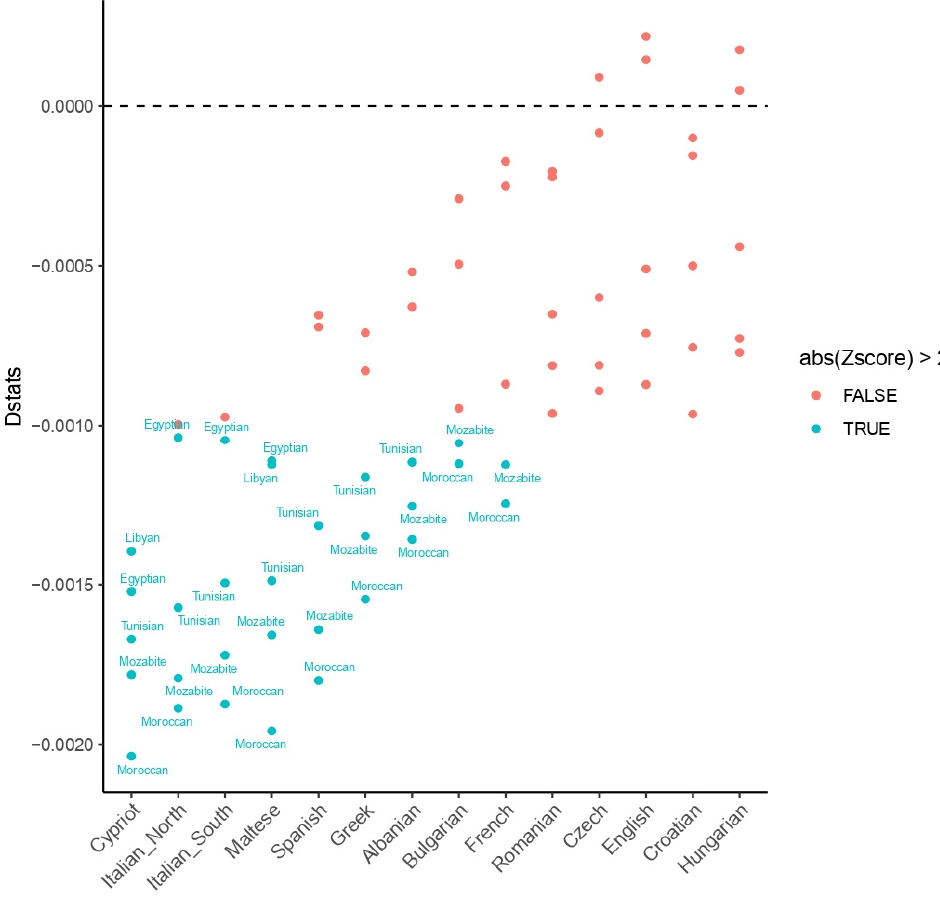
Figure 5. Visual summary of D-statistics of the form D (Papuan, CB; North Africans, Europeans). Dstats < 0: CB is more similar to the North African population in the label, Dstats > 0: CB is more similar to the European population in the x -axis. The significance of the analysis is expressed by abs (Zscore). Labels are reported only for significant analyses.